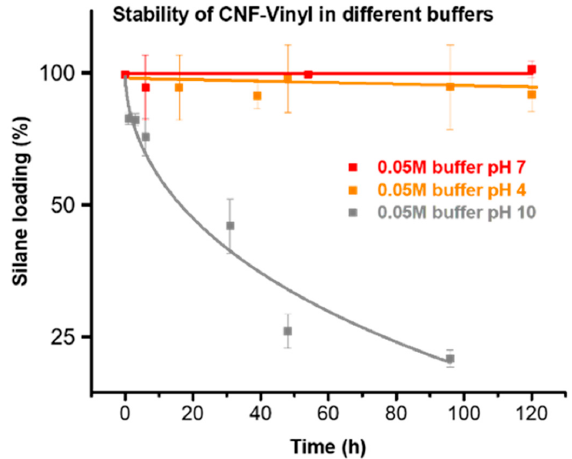
Figure 7. Stability of the vinyl-silane modified CNF under aqueous conditions at pH of 4, 7 and